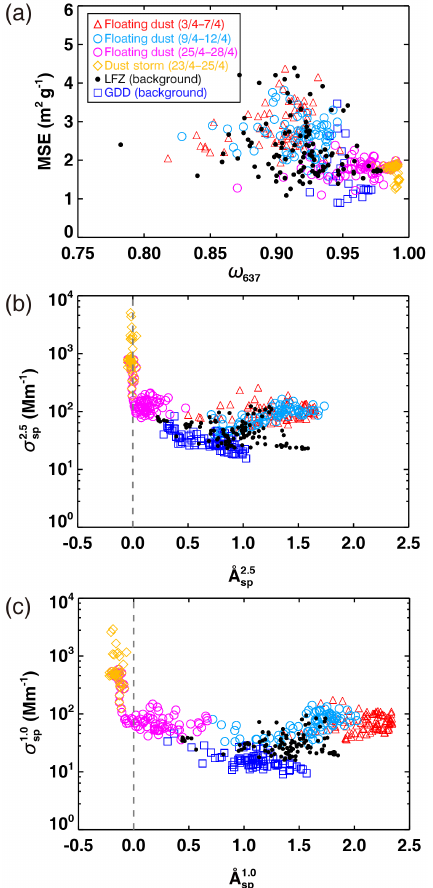
Figure 11. Scatter plot of aerosol absorption coefficients versus scattering coefficients from 3 April to 16 May 2014. The color sym- bols represent different atmospheric conditions during the dust field